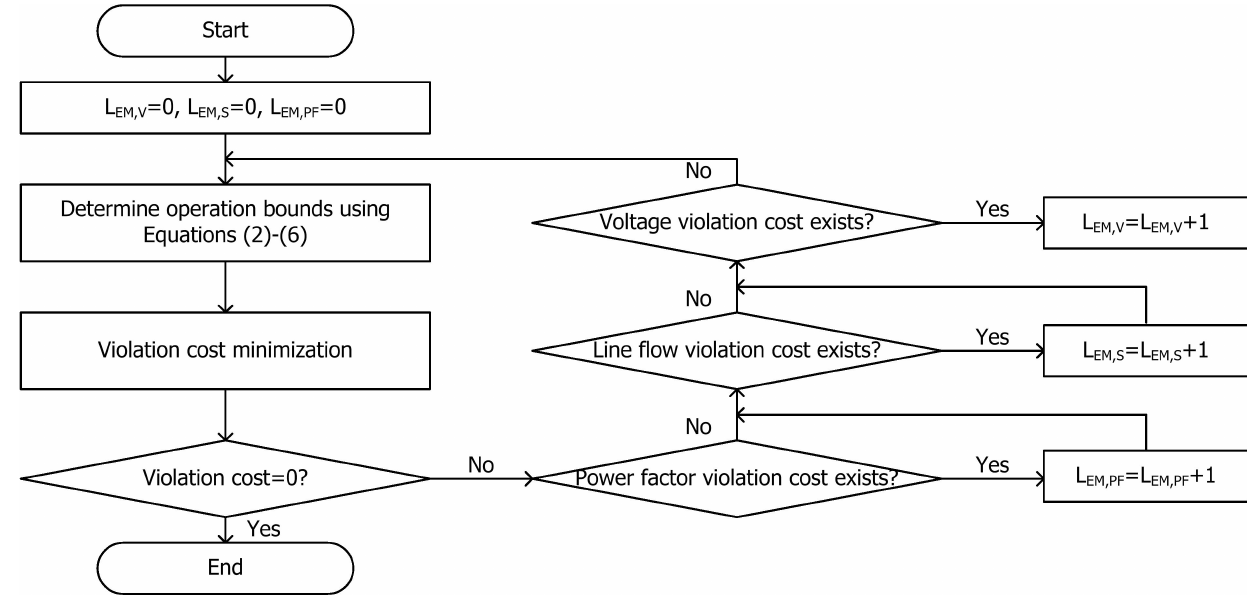
Figure 5. Flow chart of the emergency level determination